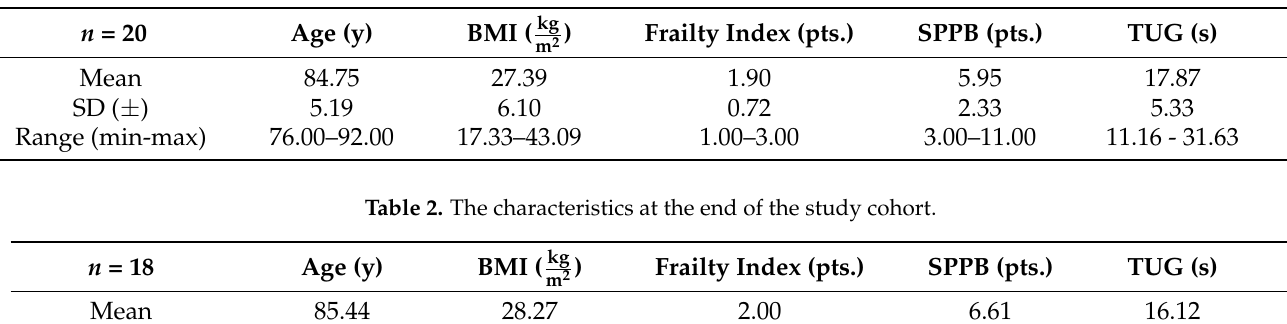
Table 1. The baseline characteristics of the study cohort.